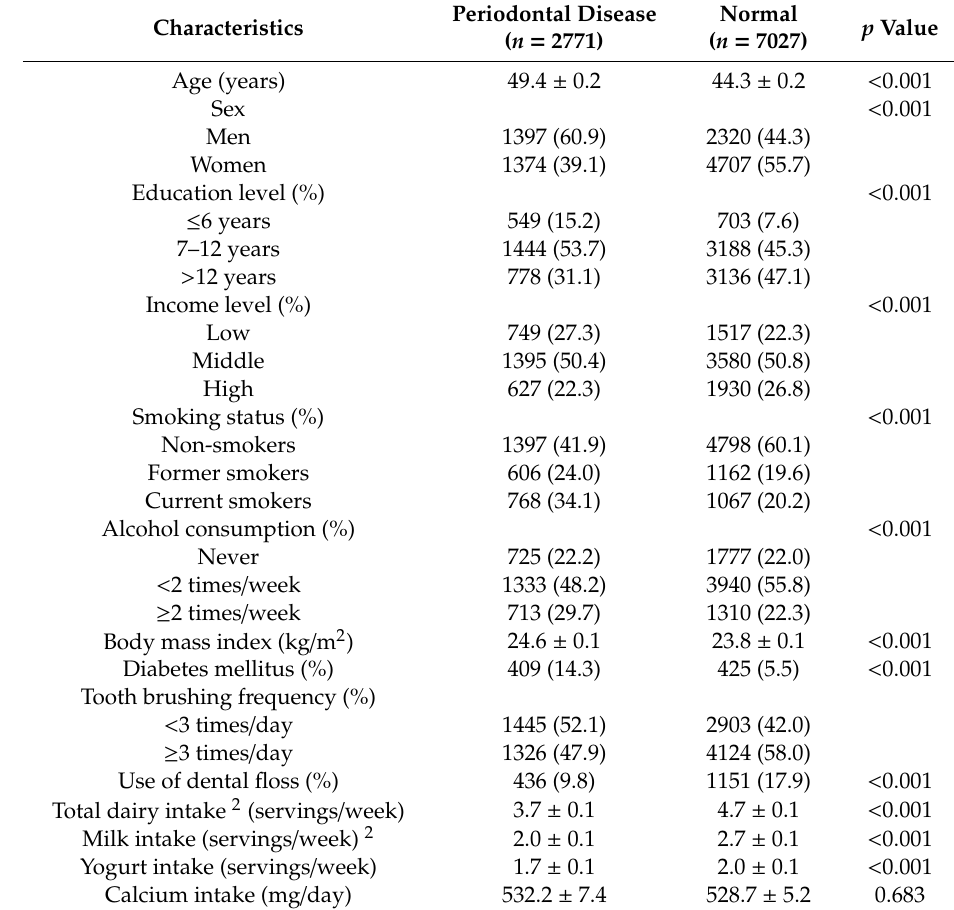
Table 1. General characteristics of participants 1